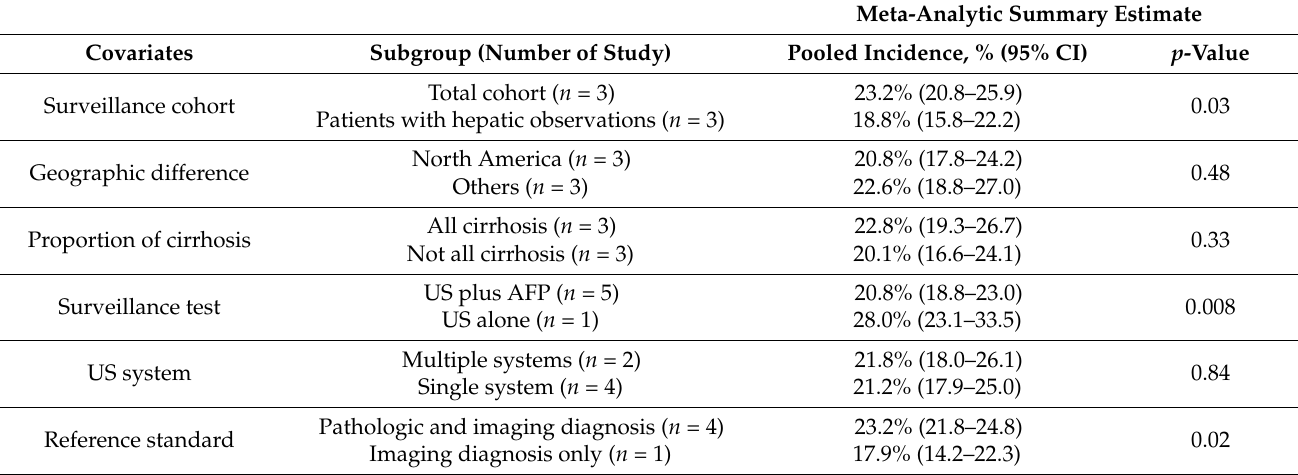
Table 2. Subgroup analysis for the incidence of inadequate US examination.